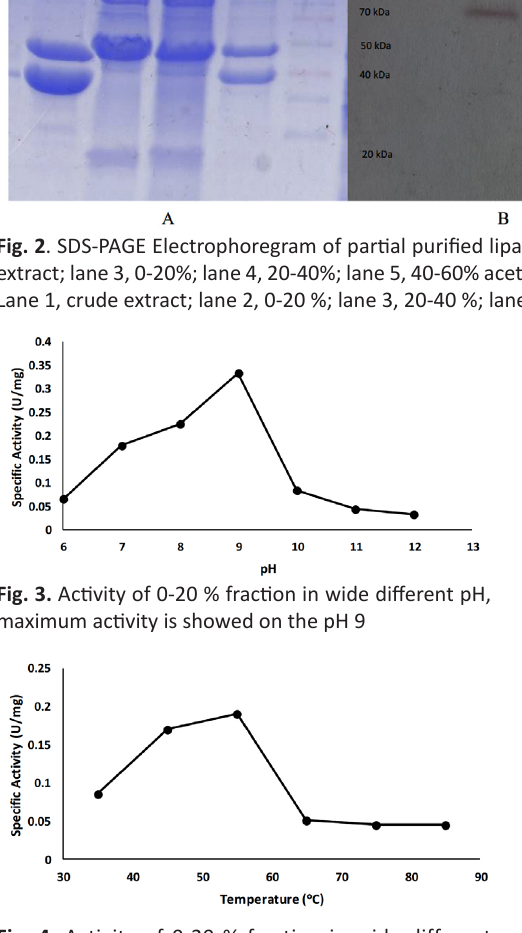
Fig. 4. Activity of 0-20 % fraction in wide different temperature, maximum activity is showed on the temperature 55°C.